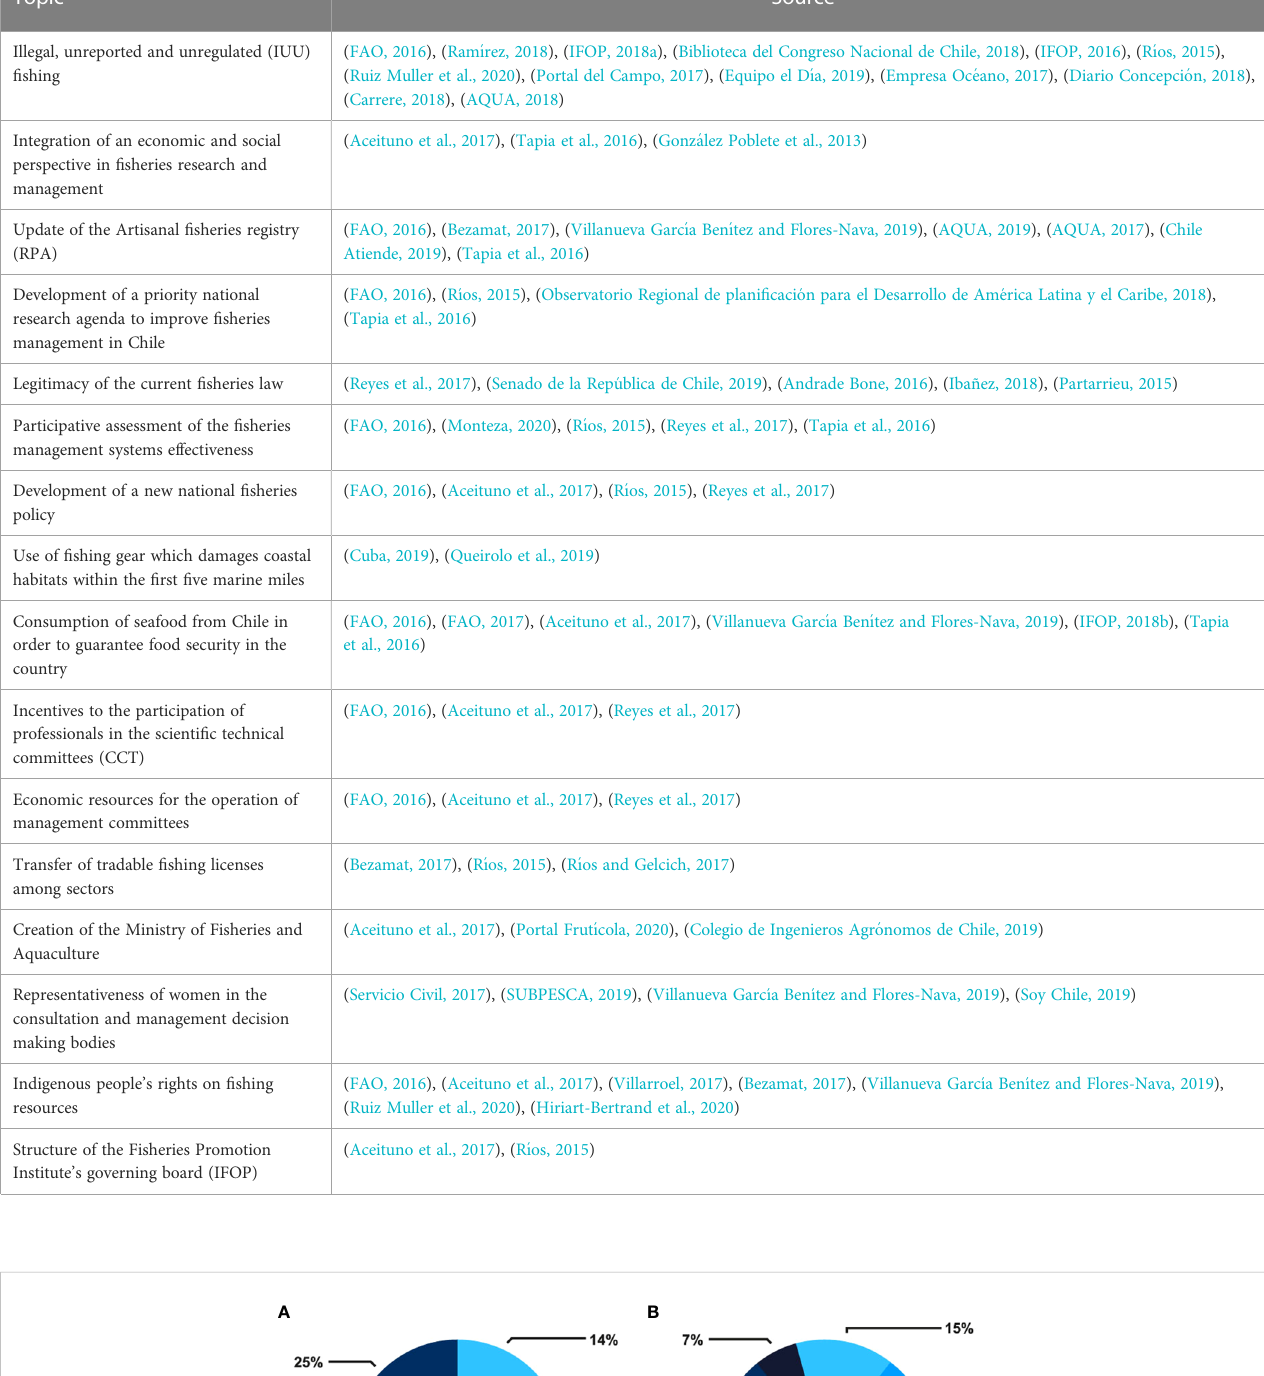
TABLE 1 Topics considered in the consultation process. Topic Source